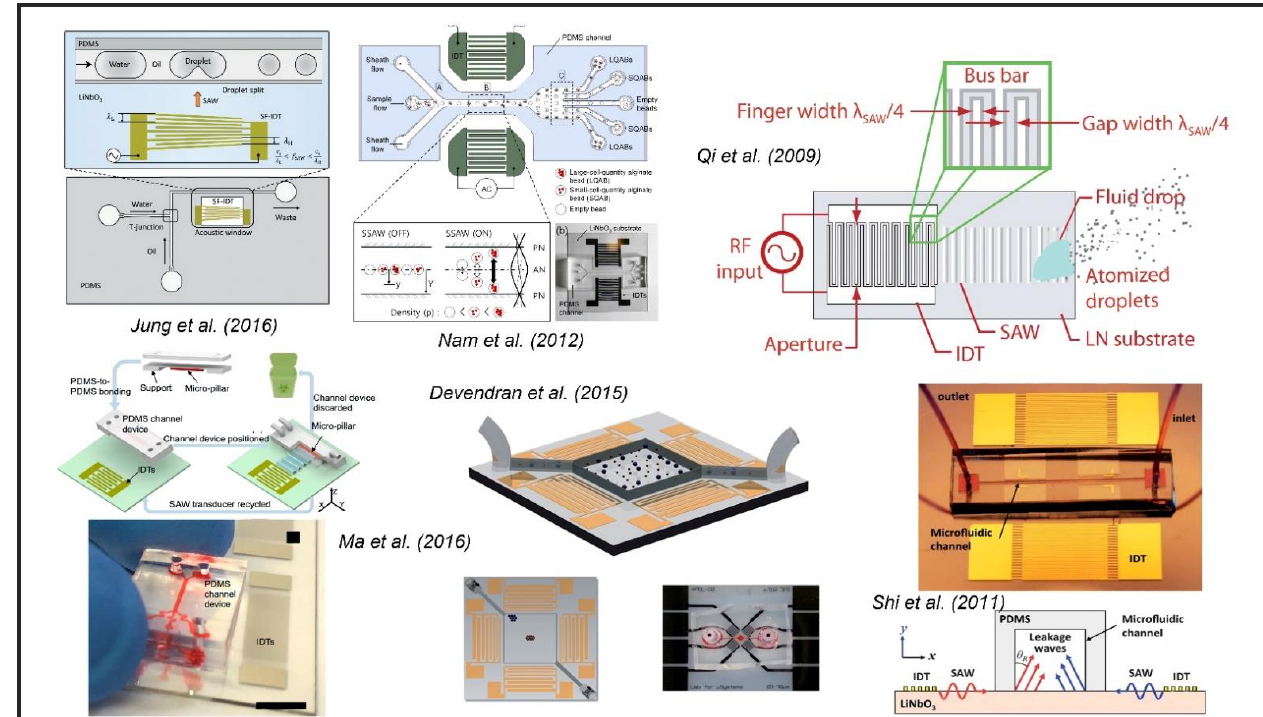
Figure 25. Various applications of SAW devices with microfluidics